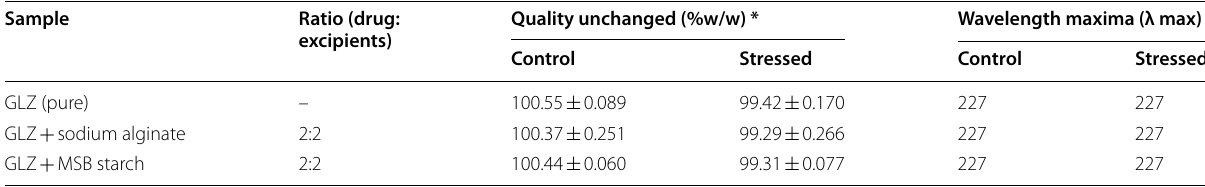
Table 3 Results of isothermal stress testing of pure drug and drug excipient mixture after 3 weeks of